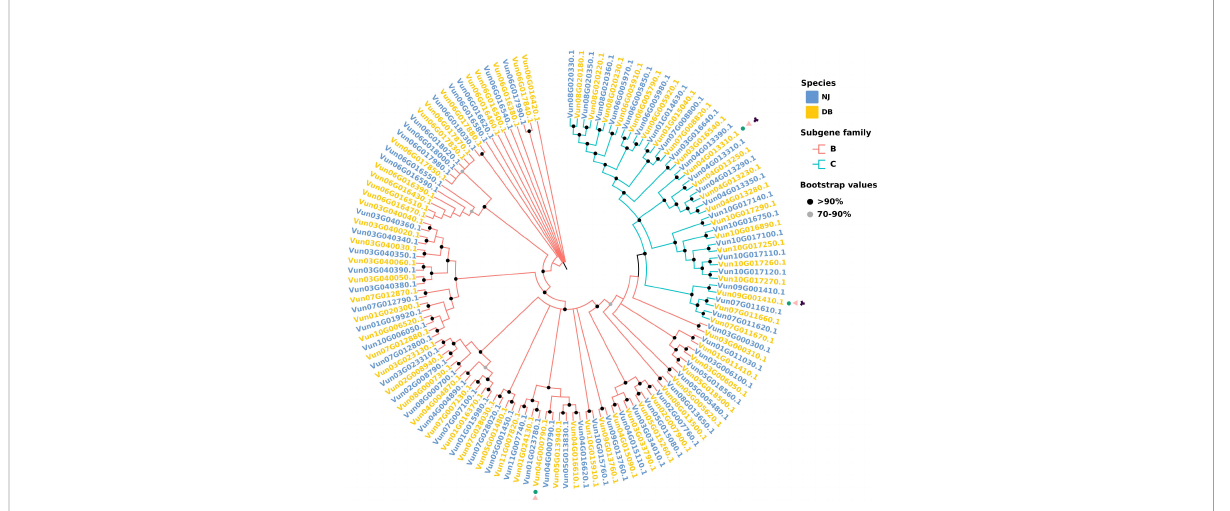
FIGURE 4 Phylogenetics of the NJ and DB ABC transporter gene families. Neighbor-joining NB-ARC tree containing gene models from both species ( P < 0.05). The red branch represents the B subgene family of the ABC transporter, and the blue branch represents the C subgene family. The red squares represent the NJ gene model, and the blue squares represent the DB gene model. In the outer circle of the phylogenetic tree, green circles represent SNP mutations in the pan-genome, =pink triangles represent InDel mutations and black diamonds represent SV mutations.